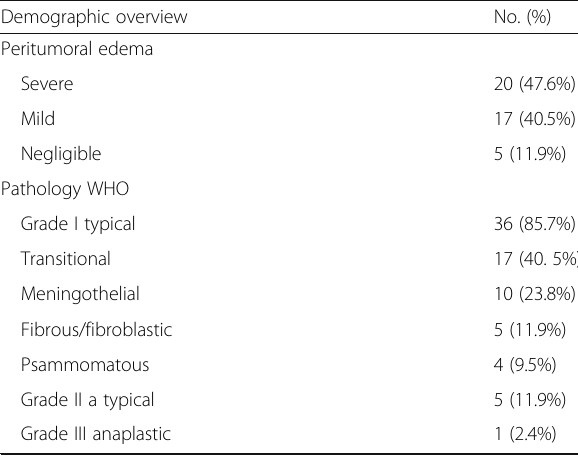
Table 1 Demographic characteristics, preoperative status, and